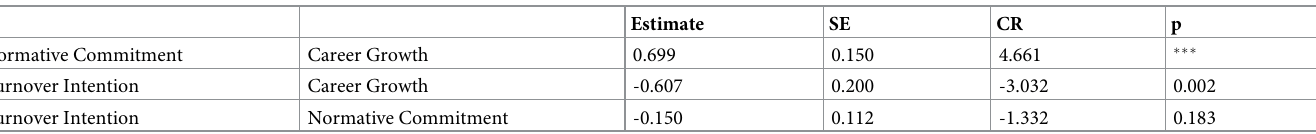
Table 15. Regression